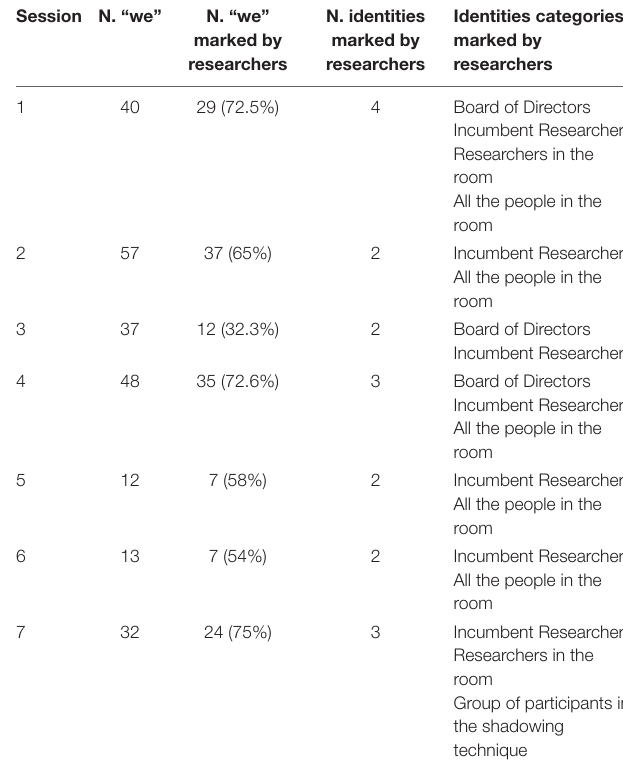
TABLE 1 | Identity categories marked by the researchers during the